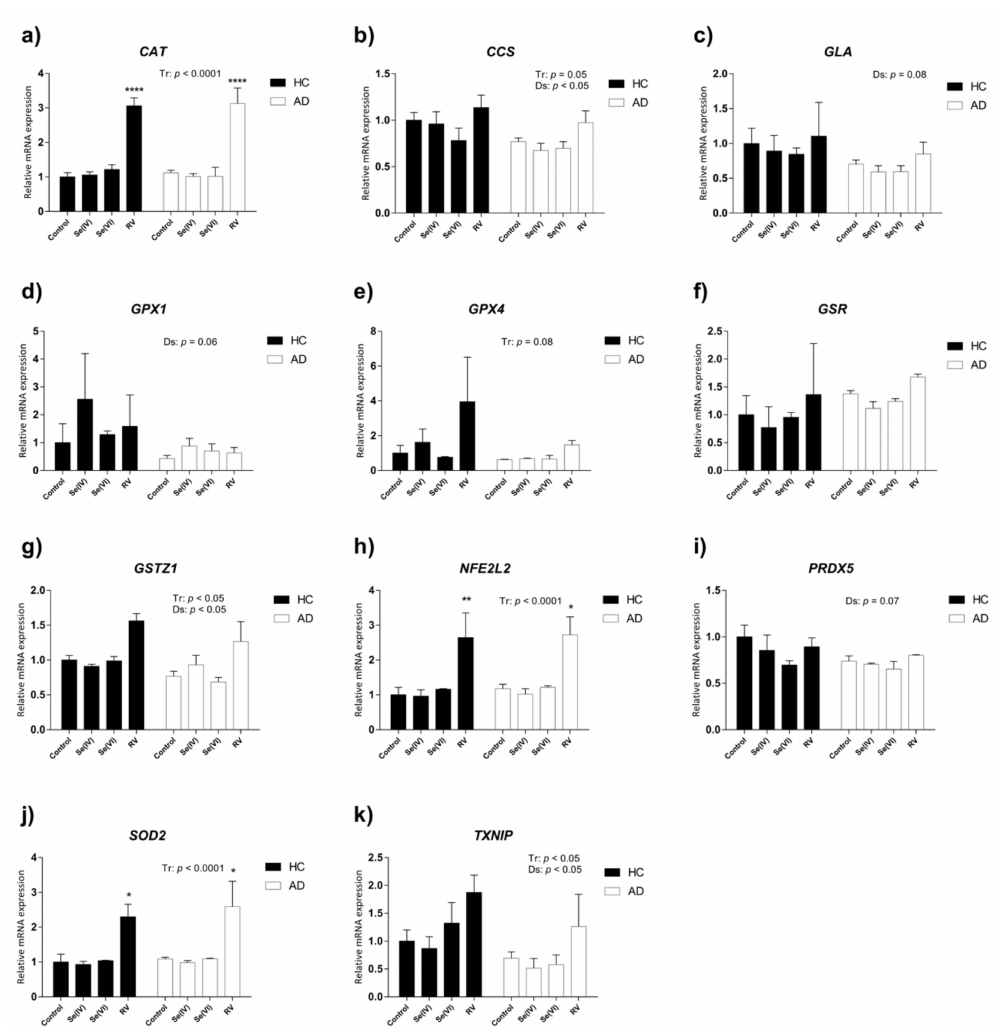
Figure 3. Relative expression of genes involved in oxidative stress in AD and HC lymphoblast cell lines treated with selenite (Se (IV)), selenate (Se (VI)), and resveratrol (RV). Gene expression analysis by real-time PCR from lymphoblast mRNA using TaqMan Fluorescein amidite (FAM)-labeled specific probes and normalized with the mean of both housekeeping genes: phosphoglycerate kinase 1 ( PGK1 ) and beta-2-microglobulin ( B2M ). ( a ) Catalase ( CAT ); ( b ) copper chaperone for SOD1 ( CCS ); ( c ) alpha galactosidase ( GLA ); ( d ) glutathione peroxidase 1 ( GPX1 ); ( e ) glutathione peroxidase 4 ( GPX4 ); ( f ) glutathione reductase ( GSR ); ( g ) glutathione S-transferase zeta 1 ( GSTZ1 ); ( h ) nuclear factor (erythroid-derived 2)-like 2 ( NEF2L2 ); ( i ) peroxiredoxin 5 ( PRDX5 ); ( j ) superoxide dismutase 2 ( SOD2 ); ( k ) thioredoxin interacting protein ( TXNIP ). P -values for two-way ANOVA analysis are indicated at the top or right area of the graph. Tr: treatment e ff ect; Ds: disease e ff ect. P -values of Tukey’s post hoc tests for each group (relative to control treatment) are indicated in the graphs as: + p < 0.1, * p < 0.05, ** p < 0.01, **** p < 0.0001. Values are mean ± SEM of two to four independent experiments with n = 2 / experiment on two di ff erent cell lines per group. HC and AD stand for healthy control and Alzheimer’s disease,